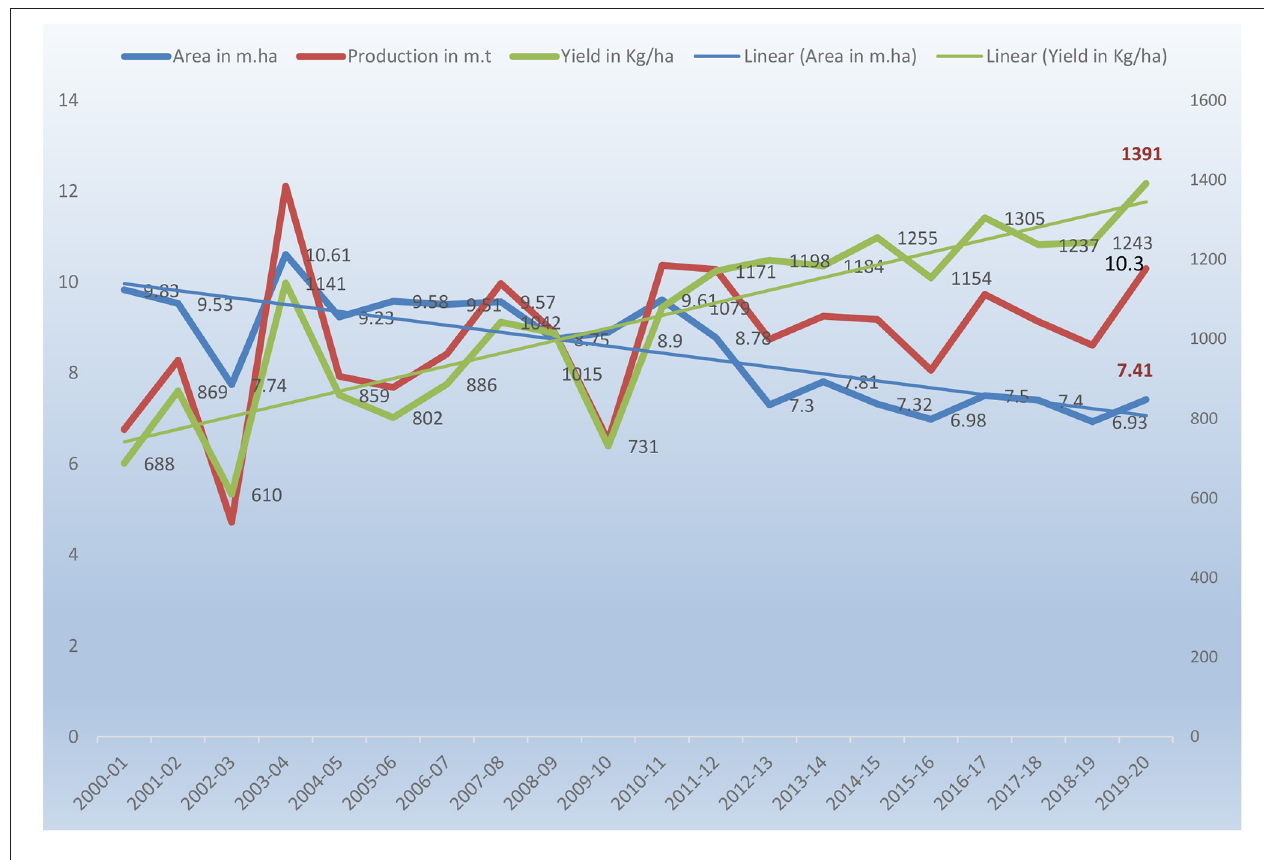
FIGURE 1 | Area, production and productivity of Pearl millet in India since